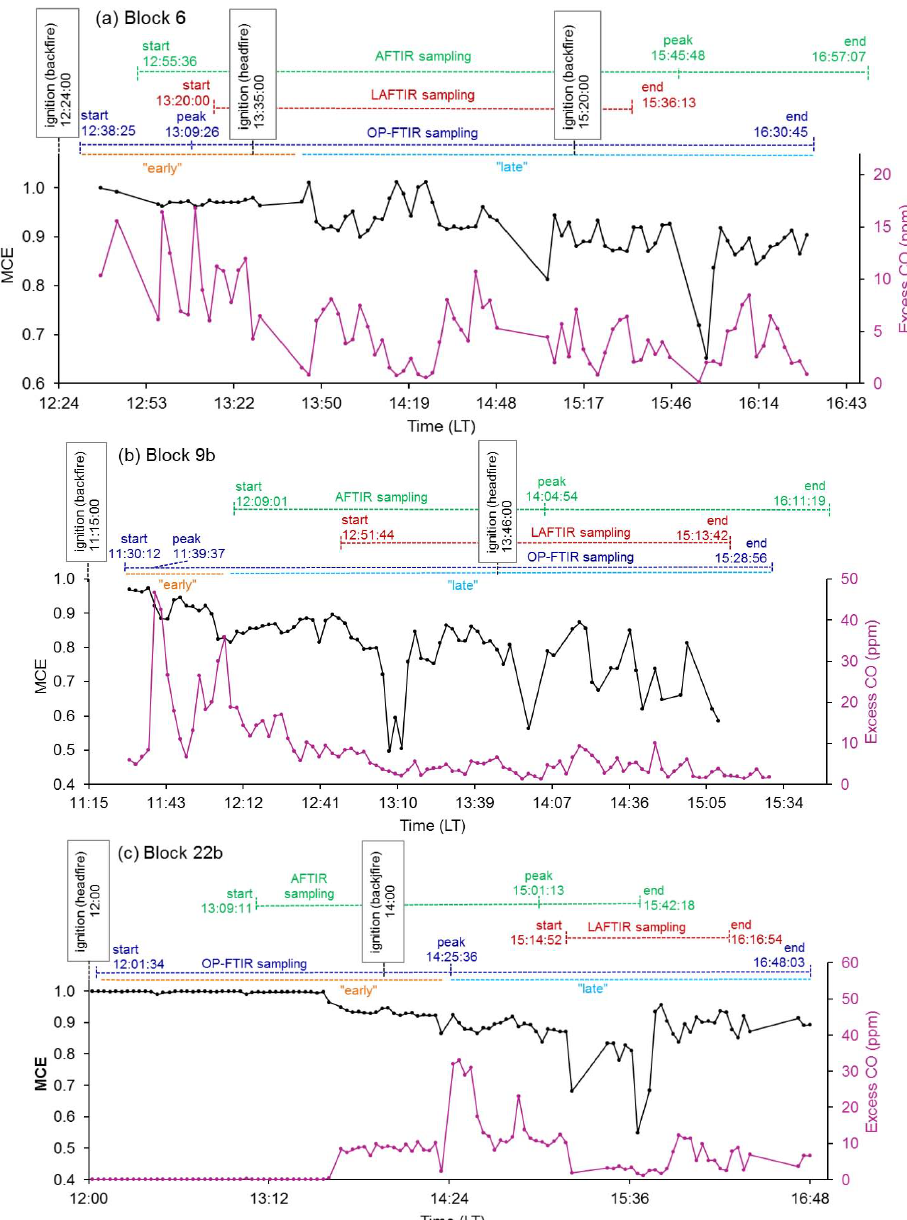
Fig. 3. MCE (black) and excess CO (ppm, pink) time series from OP-FTIR on the three Fort Jackson fires. Above the time series, AFTIR (green), LAFTIR (red), and OP-FTIR (dark blue) sampling time frames are shown to denote the start and end of measurement collection and when the “peak” intensity signal was observed from a given measurement platform. “Early” and “late” periods of OP-FTIR sampling are denoted in orange and light blue, respectively. Ignition times are shown in black to mark the lighting of headfires and backfires.